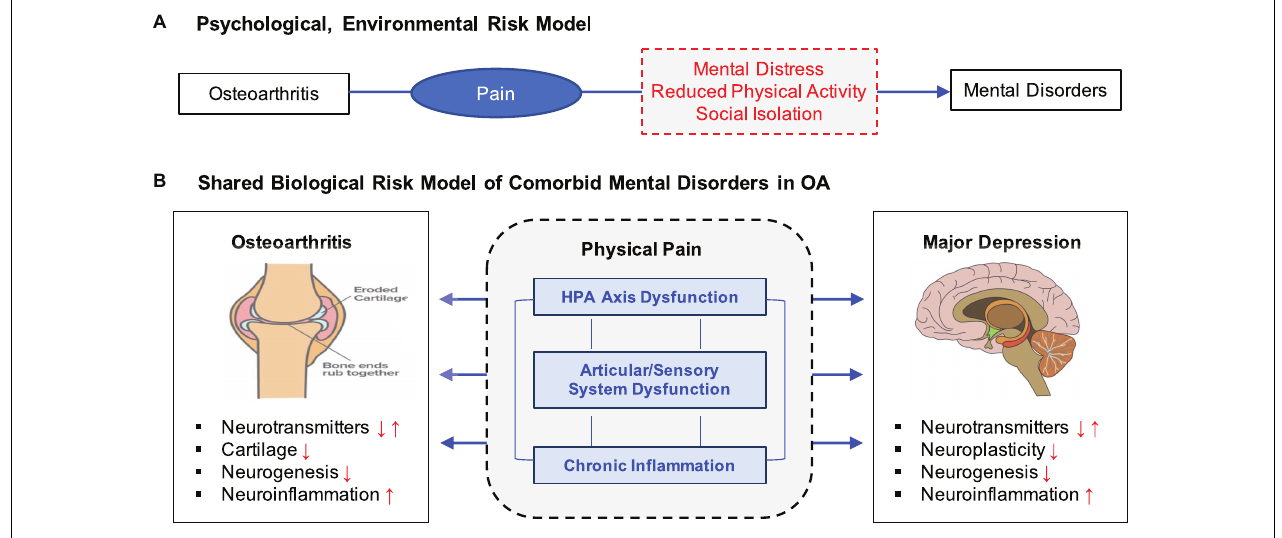
FIGURE 1 | Two distinct but not mutually exclusive risk models for OA, pain, and MD. (A) Psychological, environmental risk model attributes various negative health outcomes of OA as a major contributing factor to increasing risk to MD. (B) Shared biological risk model proposes that OA and MD are affected by some common biological mechanisms related to stress response, chronic inflammation, and articular/sensory neuronal dysfunction.